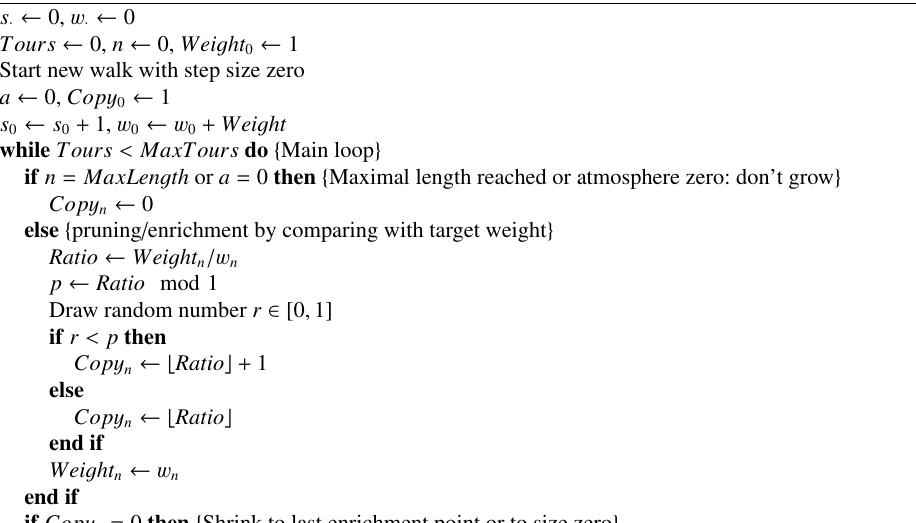
Algorithm 3 Pruned and Enriched Rosenbluth Sampling of Self-Avoiding